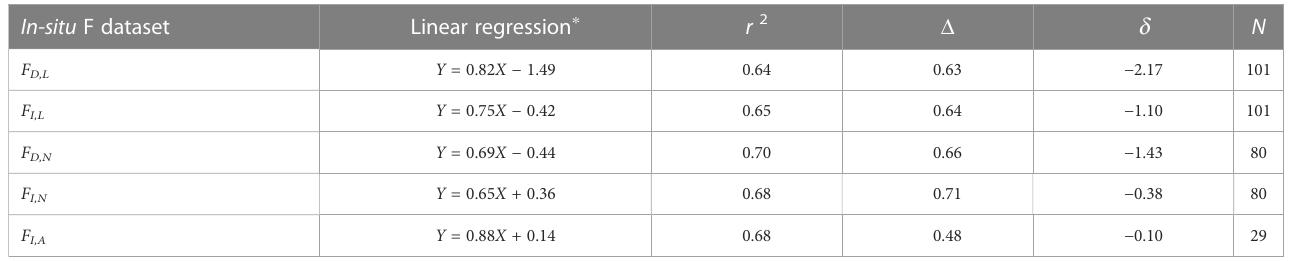
TABLE 4 Comparison of R rs -derived F using the R rs -based methods of van der Woerd and Wernand (2015) and Novoa et al. (2014) with various in-situ F datasets collected on AMT. In-situ F dataset Linear regression ∗